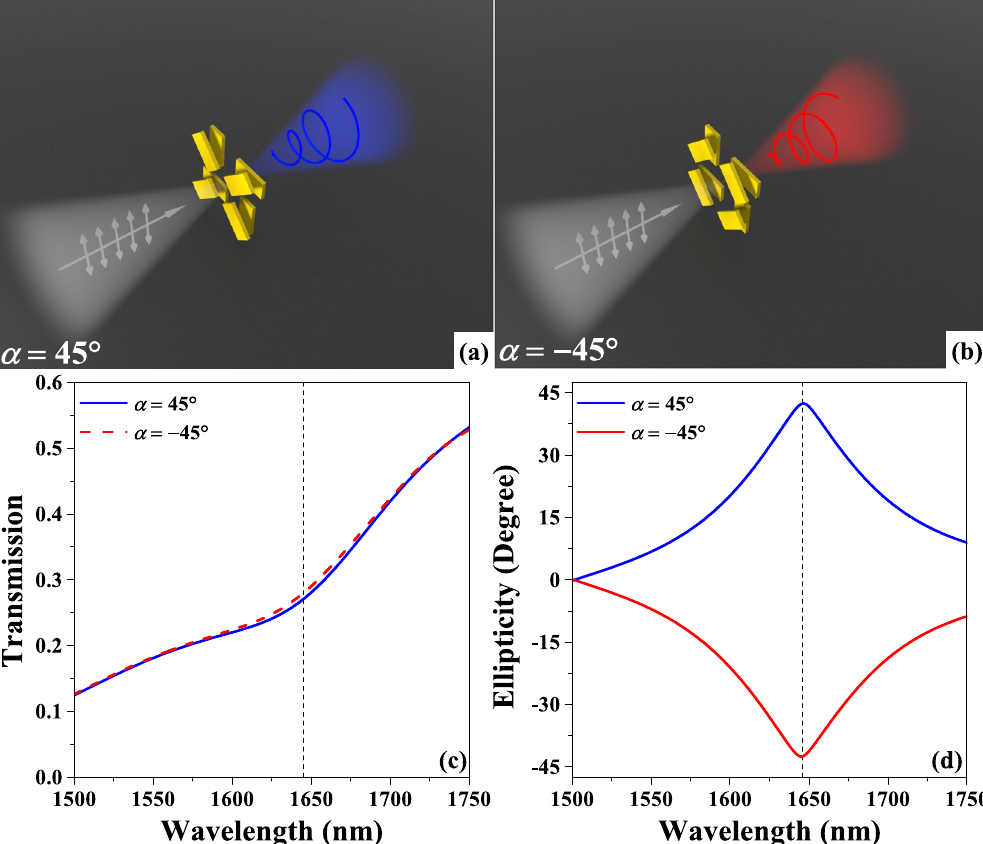
Figure 3. The performance of the designed metasurface as a spin selector. ( a ) and ( b ) Illustrations of the spin selection of the proposed two-layer metasurface with values of the orientation angle α of 45° and − 45°, respectively. ( c ) and ( d ) Simulation results for transmission intensity and ellipticity when the incidence is y -